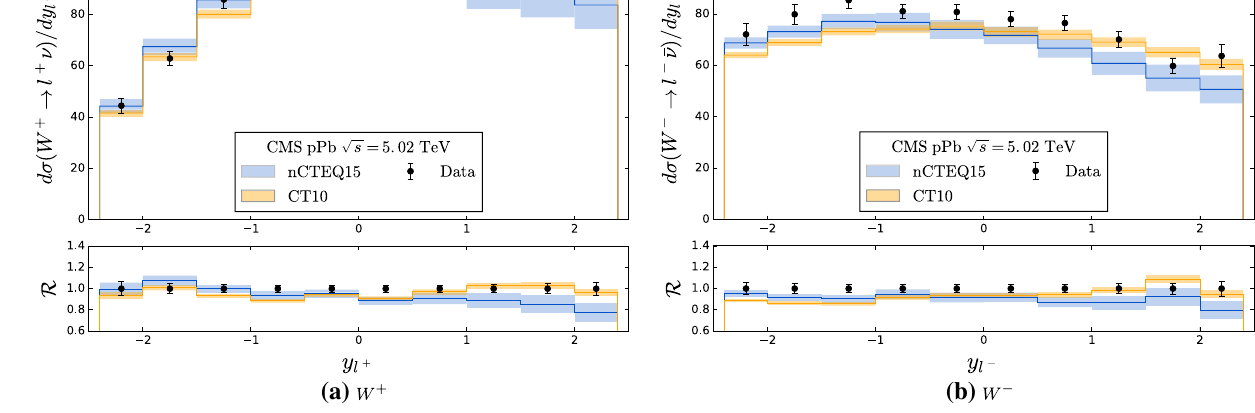
Fig. 6 CMS W ± production in pPb collisions at the LHC